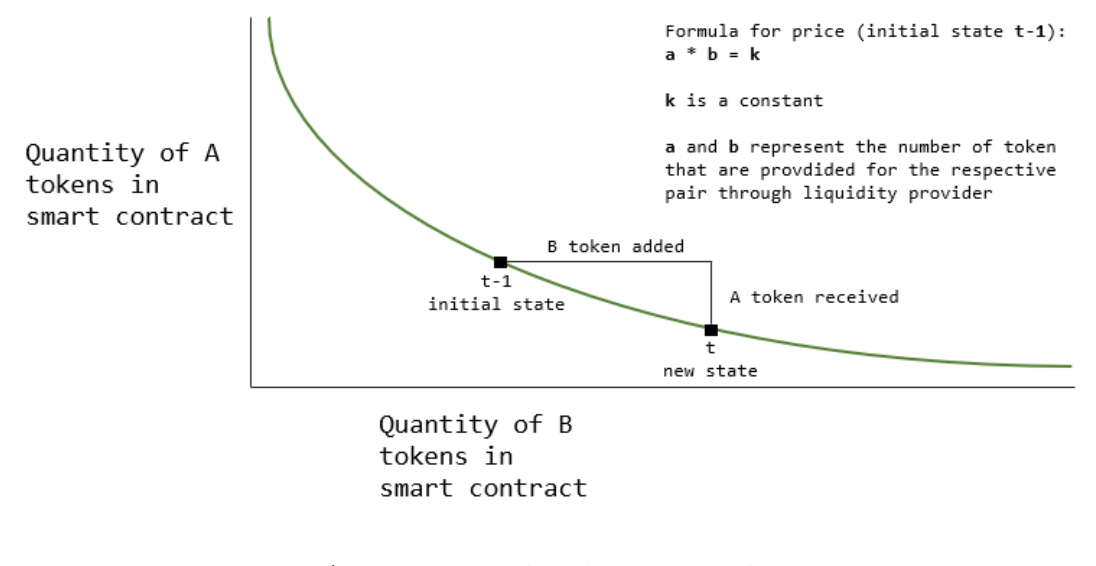
Figure 2. AMM Price Discovery